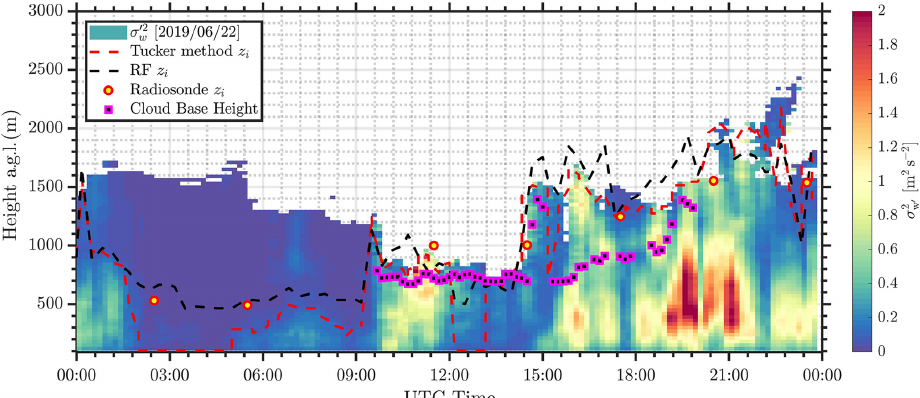
Figure 7. As in Fig. 6, but for 22 June